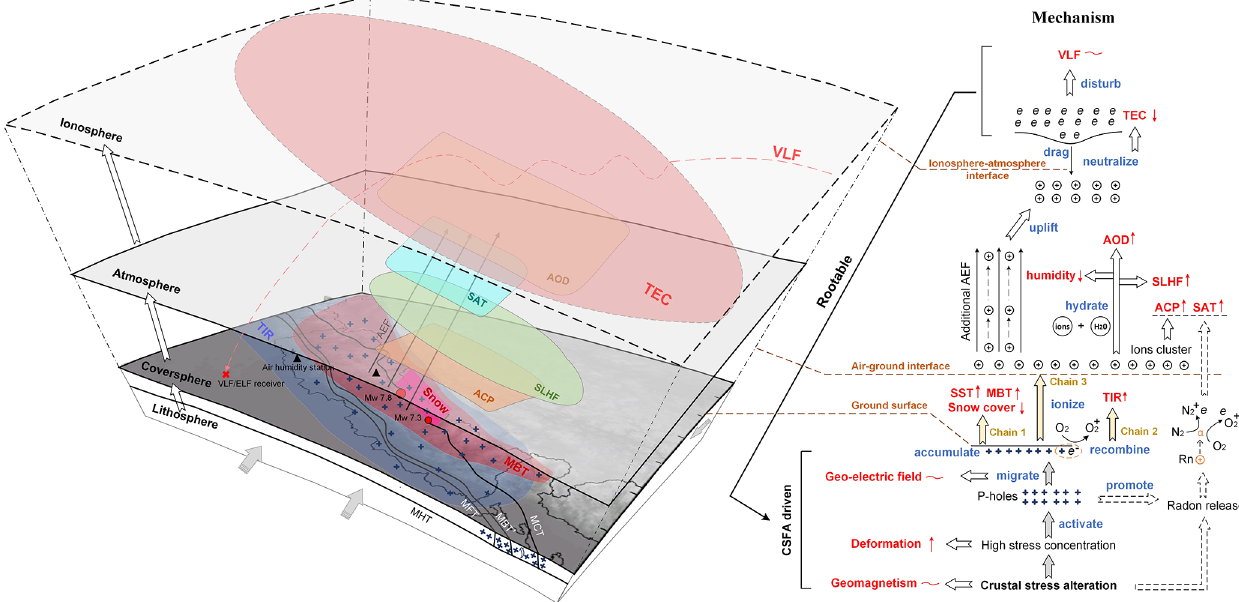
Figure 8. The integrated framework of rootable seismic anomalies as well as the evolution of LCAI coupling in a 3D manifold space. Line arrows and dashed arrows mean that the coupling actions have been verified and not been proved,